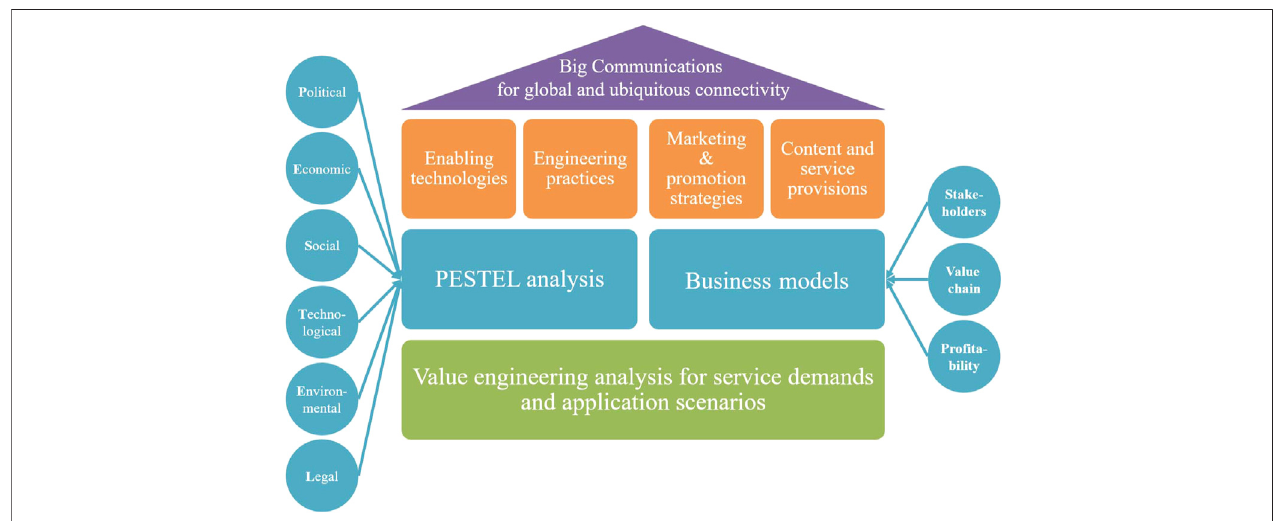
FIGURE 3 | Complete framework of BigCom for achieving global and ubiquitous connectivity and democratizing the bene fi ts of ICT.